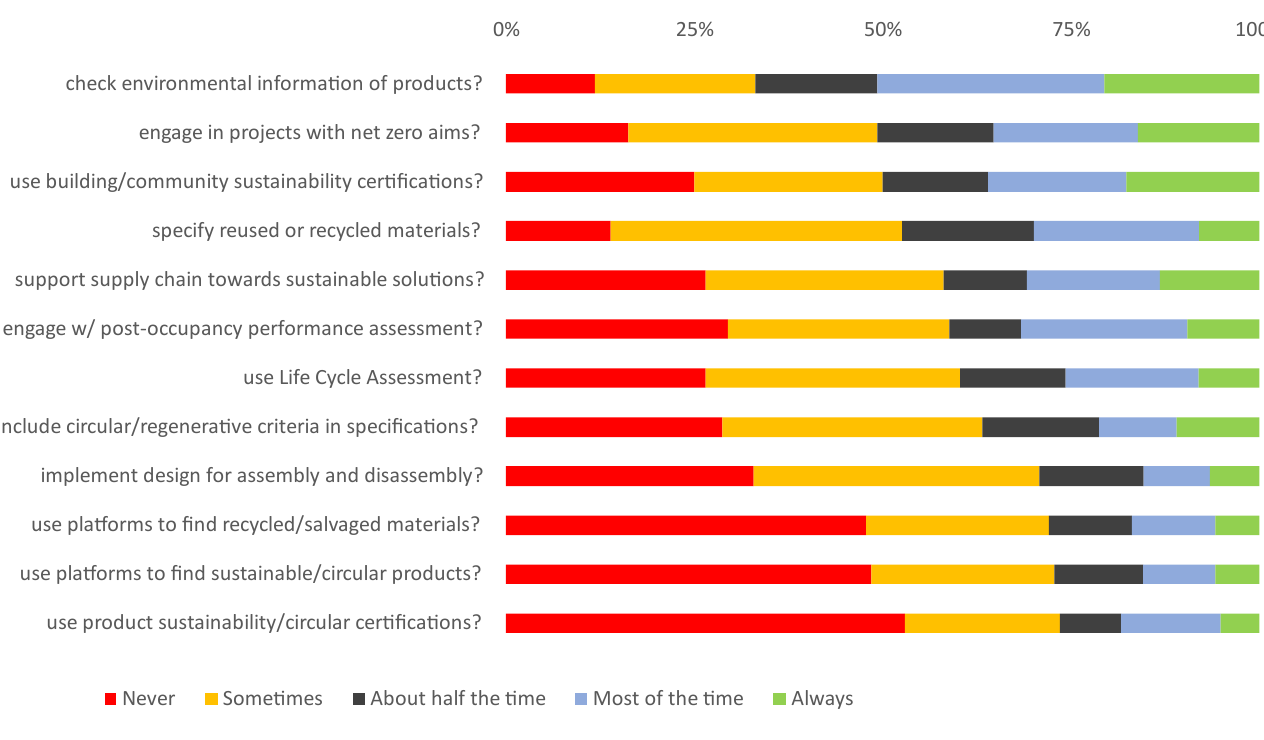
Figure 7. Frequency of practices that support a regenerative and circular approach. More than half of the professionals (51%) check the environmental information of the products or components they specify, buy or use, most of the time or always, and 67% do it at least half the time. 50% engage with building or community-level certification